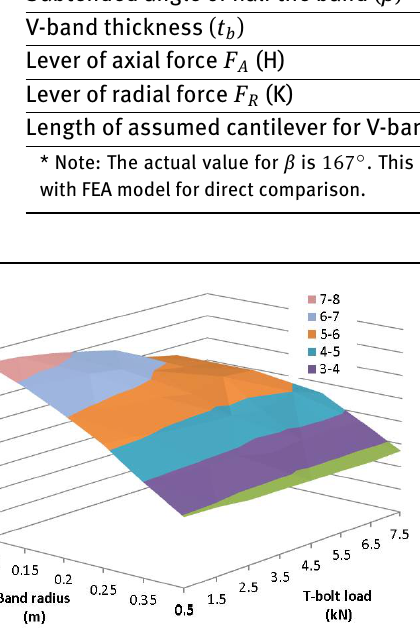
Figure 13: Axial stiffness based on ring expansion and combined theories with friction coefficients of 0 and